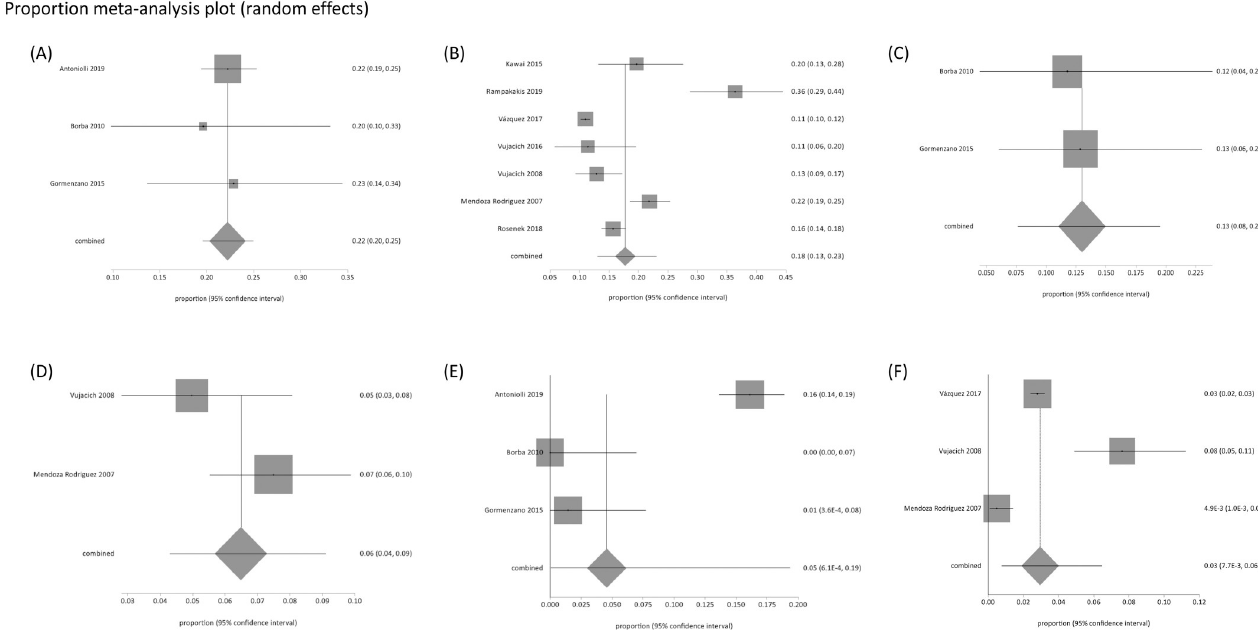
Fig 2. HZ complications in immunosuppressed patients versus immunocompetent patients. (A) PHN in immunosuppressed patients (B) PHN proportion in immunocompetent patients (C) Secondary bacterial infection in immunosuppressed patients (D) Secondary bacterial infection in immunocompetent patients (E) DHZ in immunosuppressed patients (F) DHZ in immunocompetent patients.